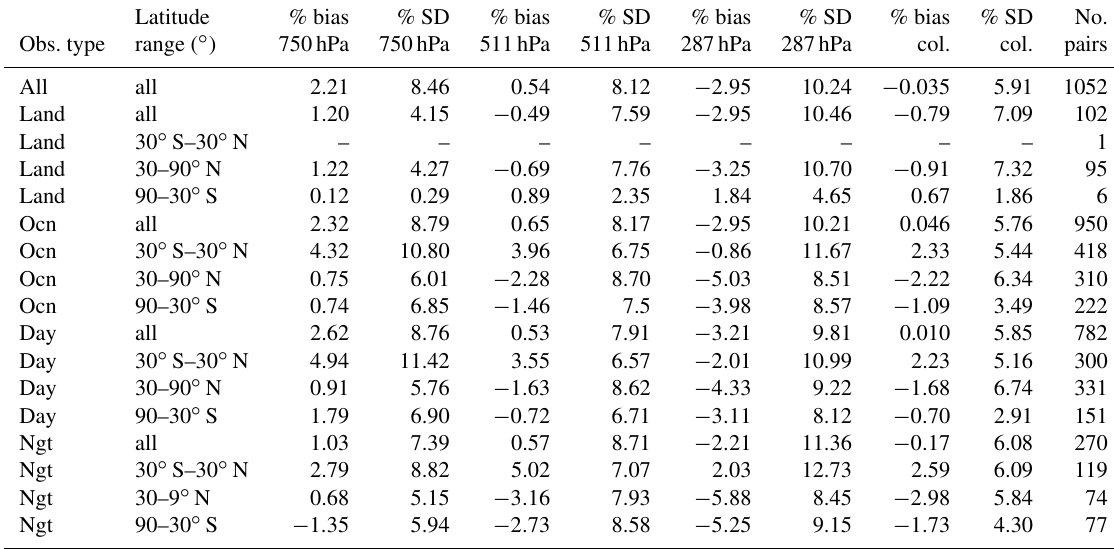
Table 3. Bias and standard deviation (SD) for comparisons of SNPP TROPESS/CrIS CO retrievals and in situ CO profiles from ATom flight campaigns